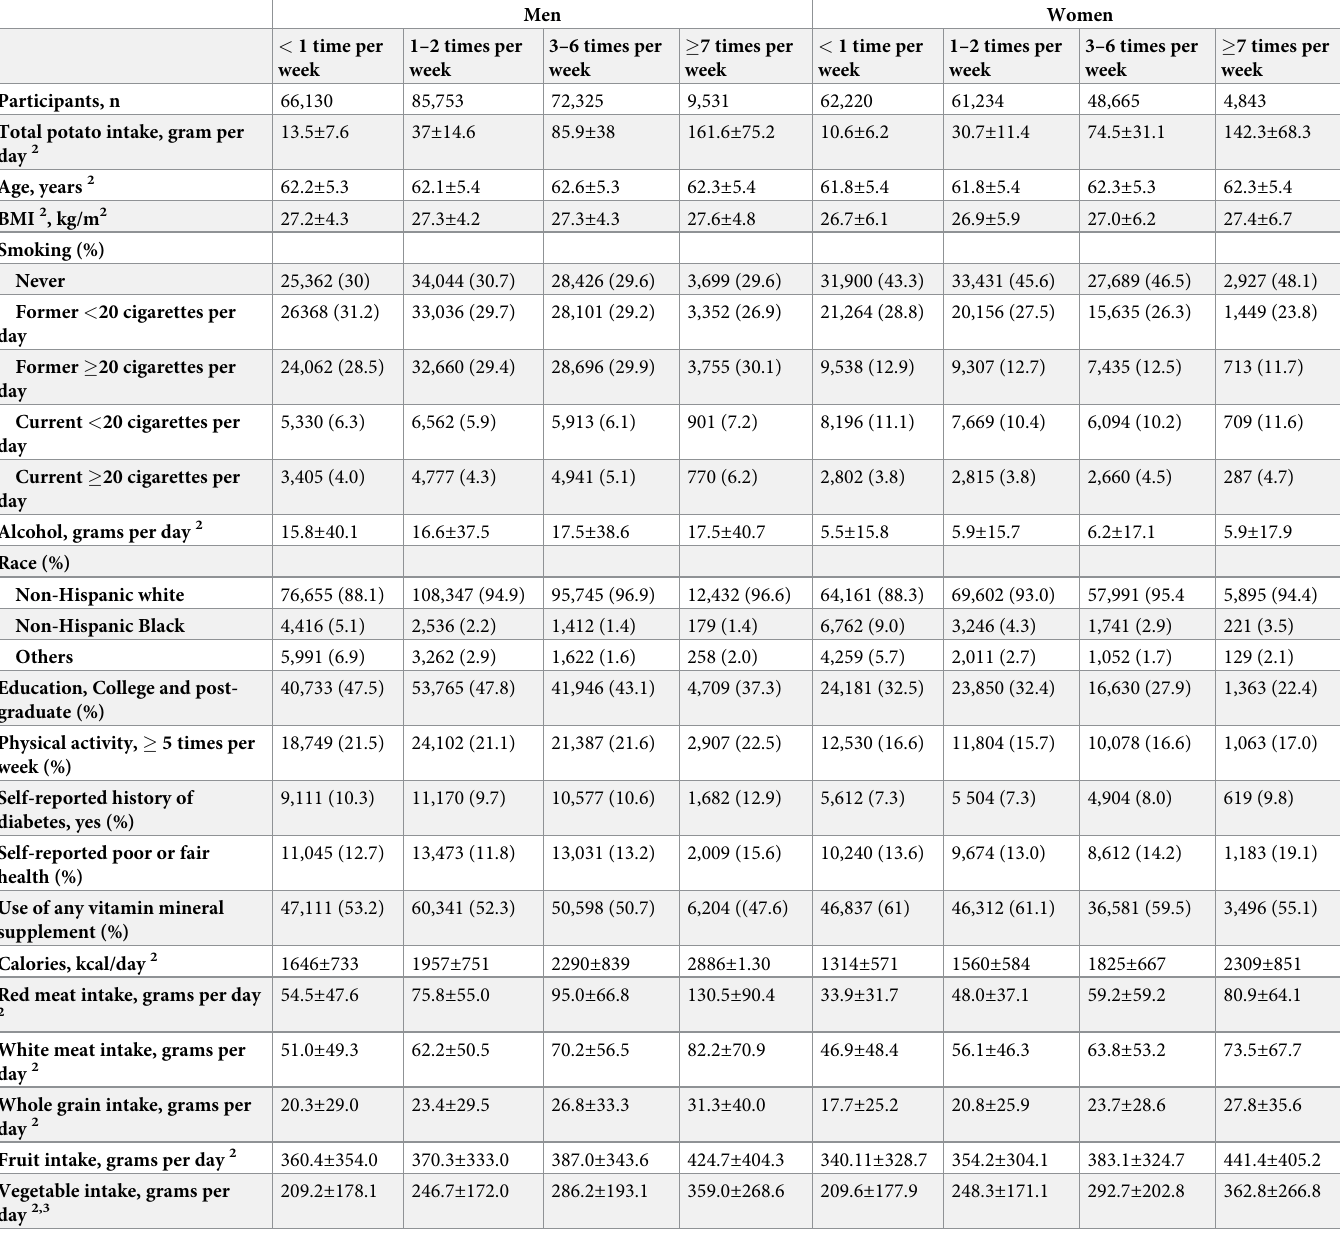
Table 1. Demographic and dietary characteristics of participants by potato consumption in the NIH-AARP diet and health study 1 . Men